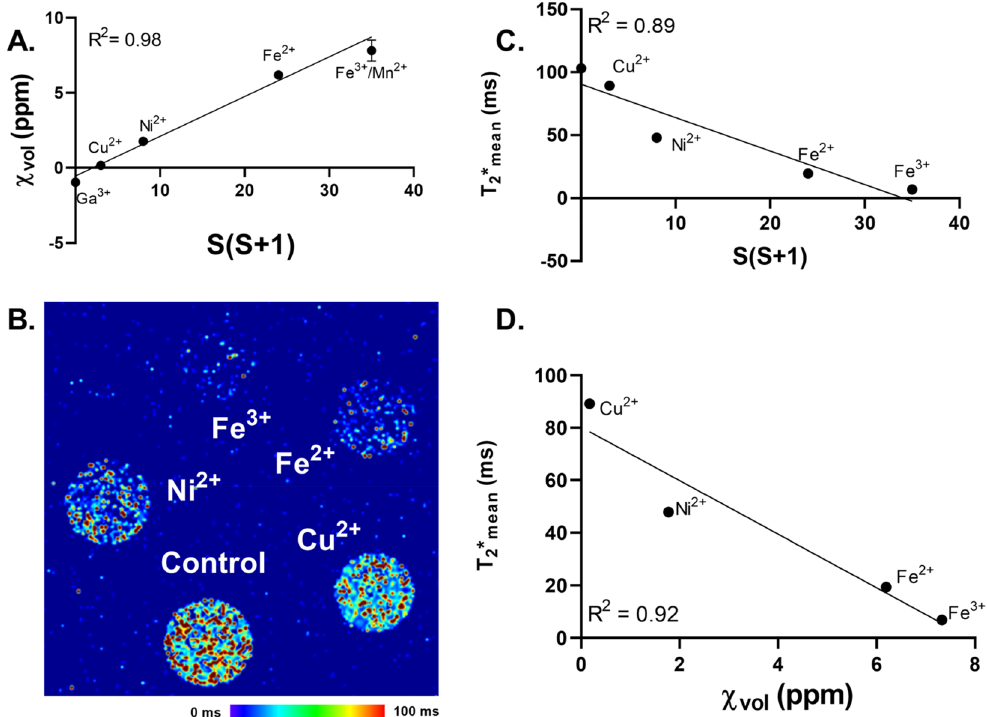
Figure 1. T 2 * and χ vol is directly proportional to the number of unpaired electrons. Volumetric magnetic susceptibility measures were taken of 1 M concentrations of Ga(NO 3 ) 3 (Ga 3+ ), CuSO 4 (Cu 2+ ), NiCl 2 (Ni 2+ ), (NH 4 ) 2 Fe(SO 4 ) 2 ·6H 2 O (FAS, Fe 2+ ), Fe(NO 3 ) 3 (Fe 2+ ), and MnSO 4 (Mn 2+ ) in 4 mm O.D. quartz EPR tubes. Samples were prepared at room temperature (25 °C). ( A ) Linear correlation between experimentally determined volumetric magnetic susceptibility and the spin-only magnetic moment of various inorganic species. Each metal was left unchelated and diluted in double-distilled H 2 O at a 1 M concentration. ( B ) T 2 * map of transition metals (100 µM) embedded in a 1% agarose gel and scanned using a 7 T scanner. ( C ) Linear correlation between experimentally determined T 2 * relaxation times and the spin-only magnetic moment of various inorganic species. ( D ) Linear correlation between T 2 * relaxation times and volumetric magnetic susceptibilities determined experimentally. Each experiment was done with triplicate